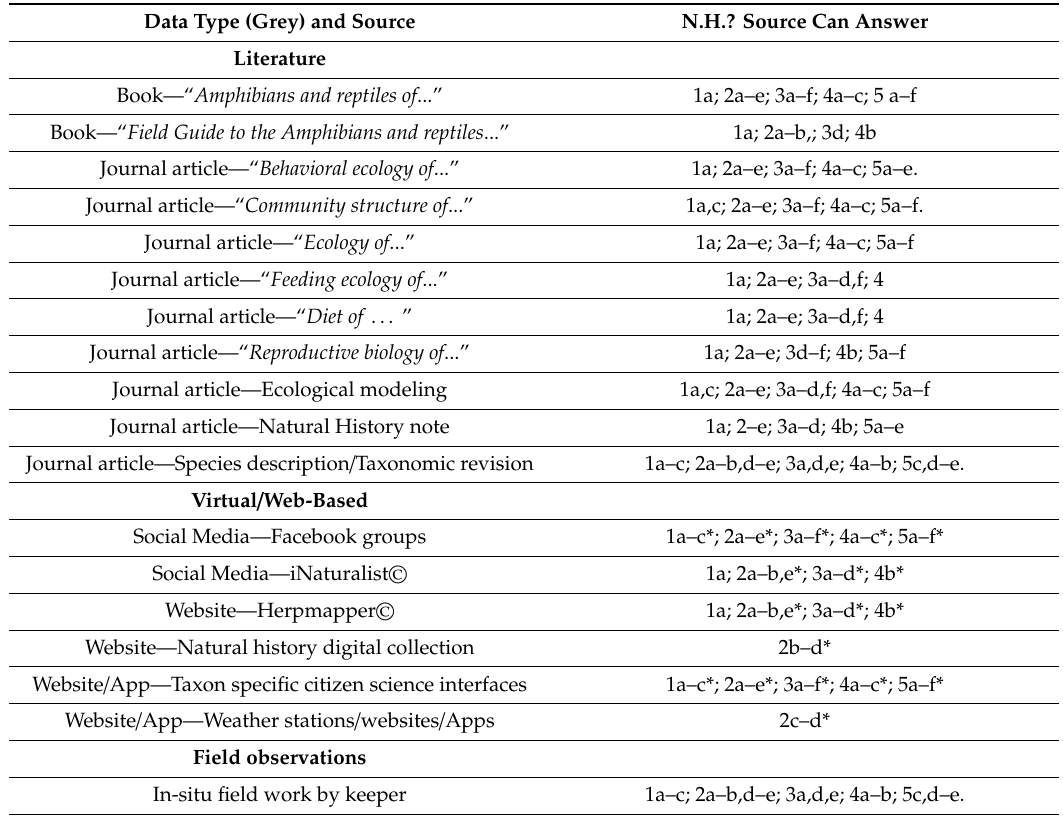
Table 3. Data sources and the associated broad (numbers) and sub (lower case letters) Bartholomew natural history questions they aid in answering. Asterisks indicate data types / sources that need validated with additional